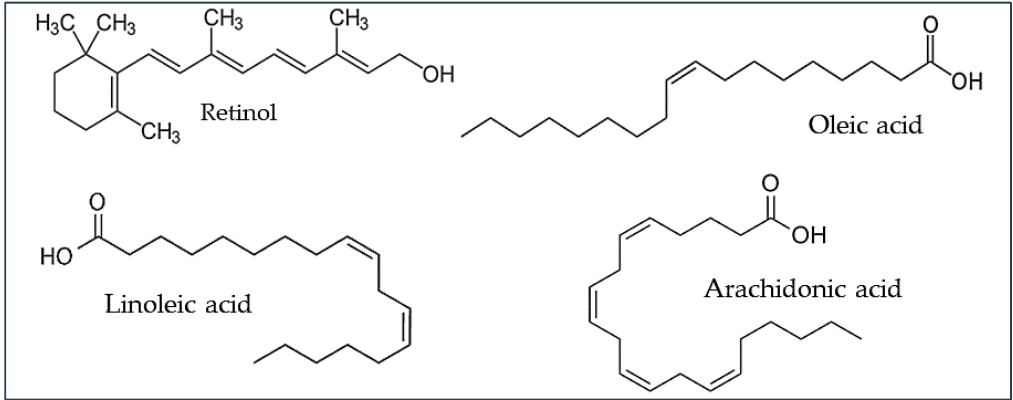
Figure 7. Structure formulae and pure compounds.